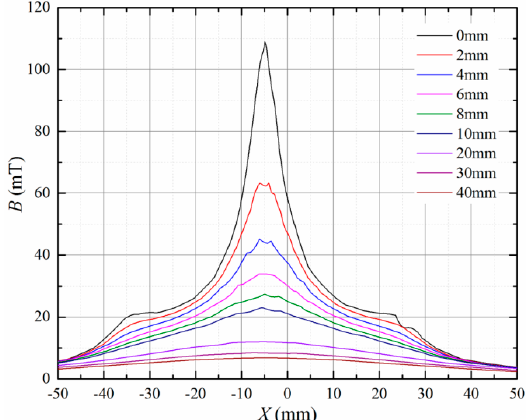
Figure 4. Variation of the magnetic flux density over z-height.